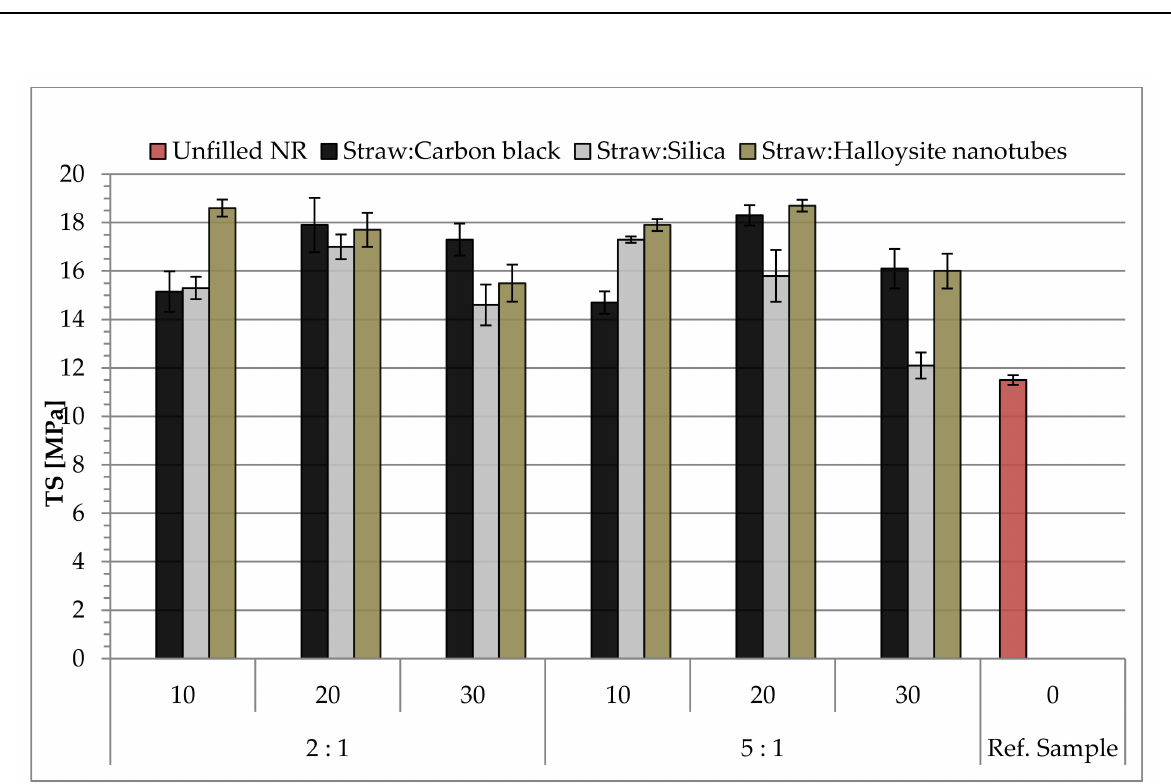
Figure 14. Tensile strength (TS) values of composites filled with straw:nano-additive